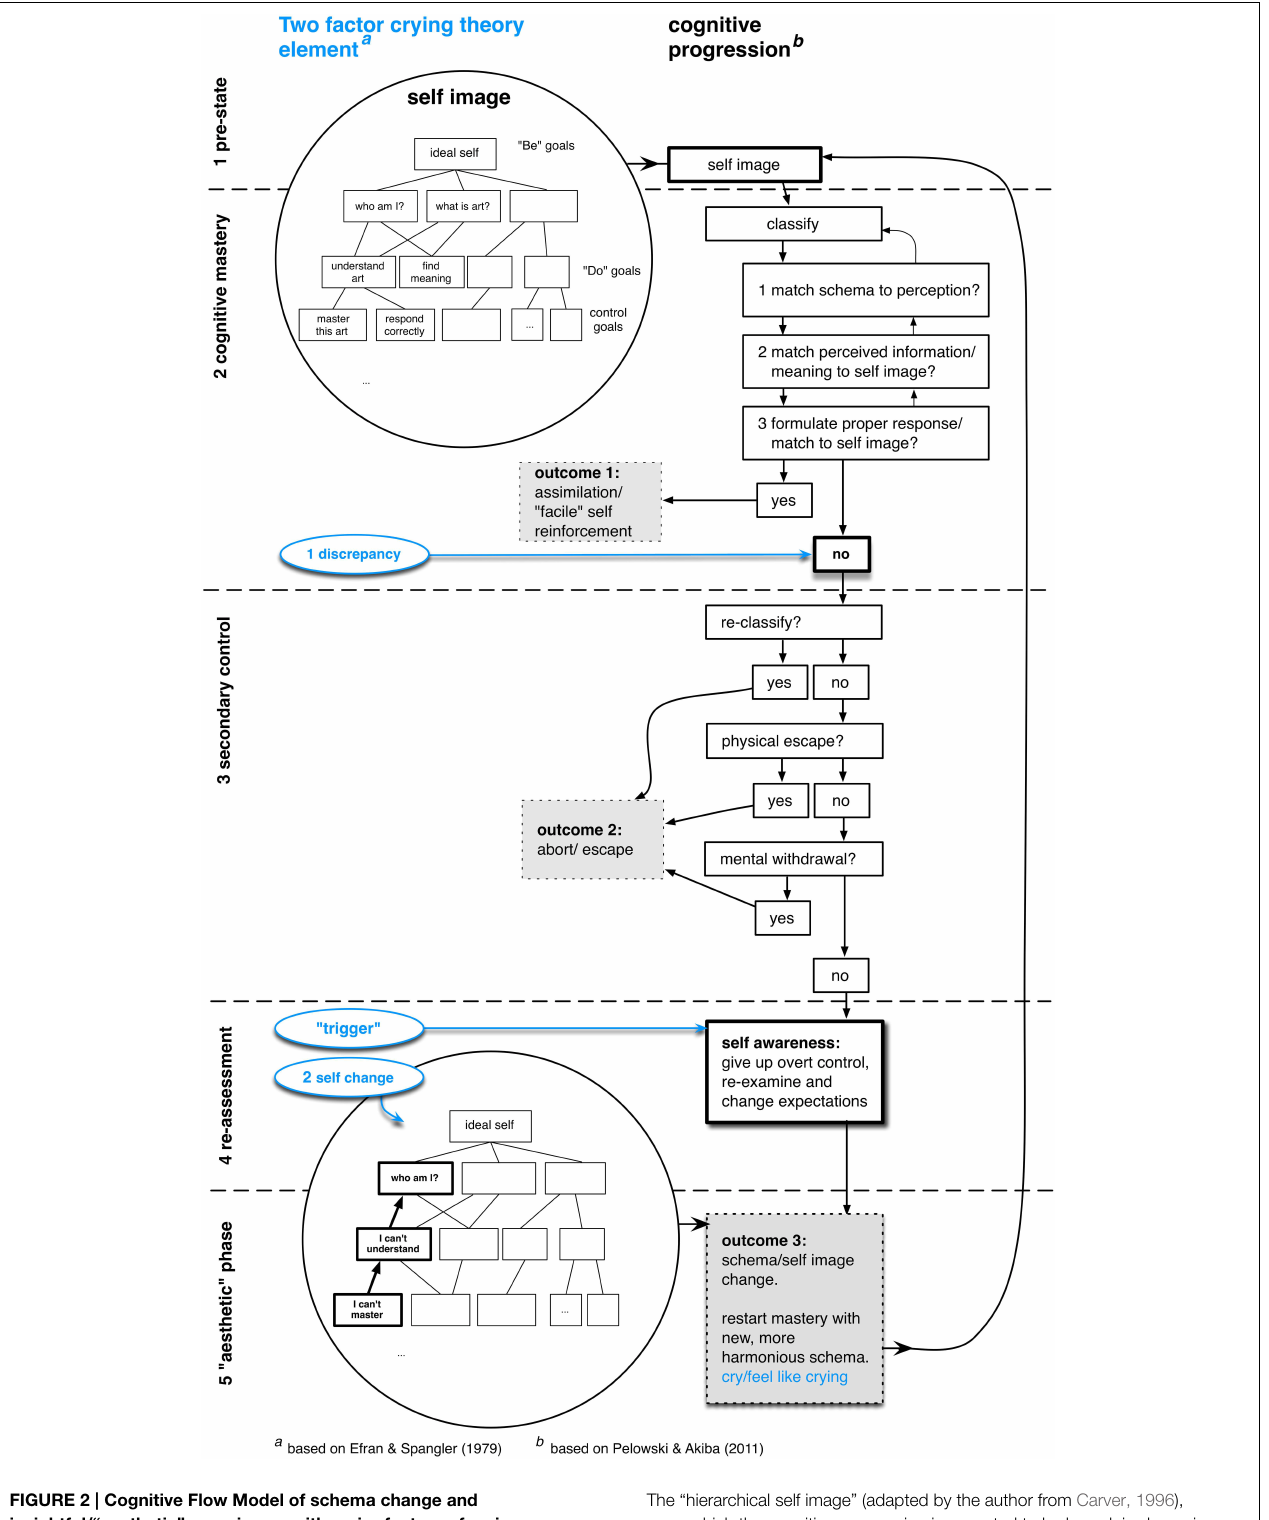
FIGURE 2 | Cognitive Flow Model of schema change and insightful/“aesthetic” experience, with major factors of crying highlighted. The main flow model (based on Pelowski and Akiba, 2011) is depicted on the right, and can be read from top to bottom, with major stages denoted on the far left and three posited outcomes depicted in gray boxes.